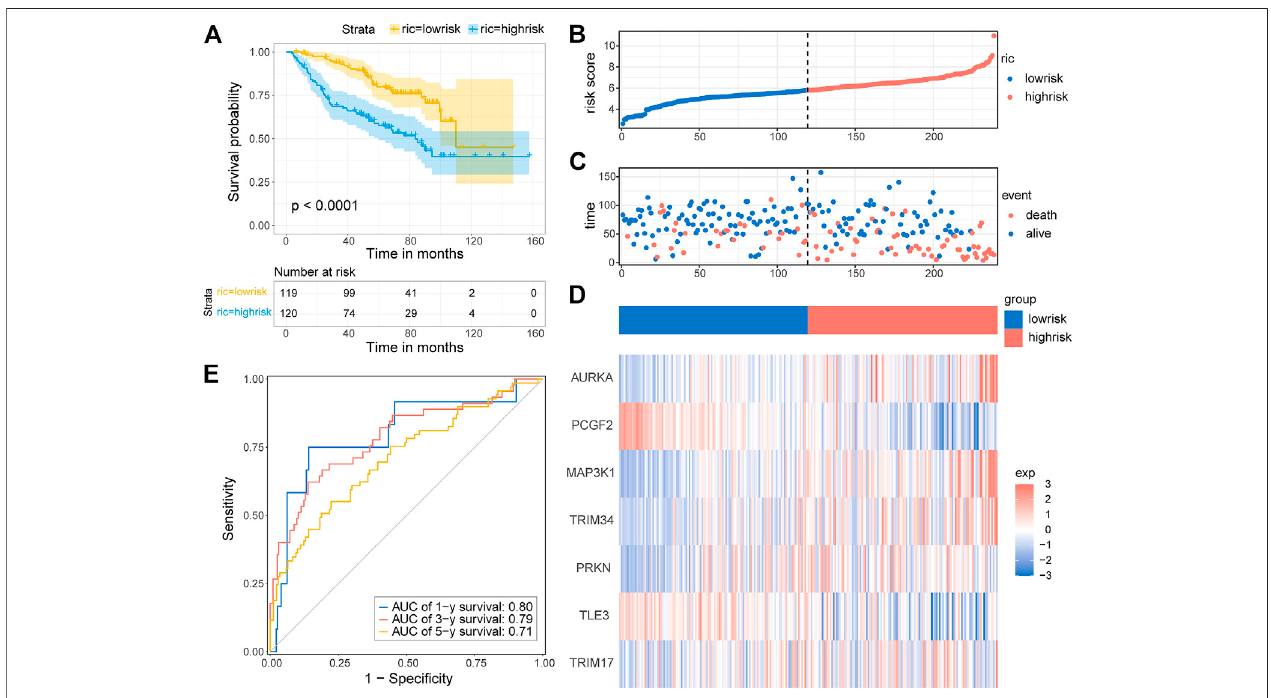
FIGURE 6 | Validation of the E3RG prognostic signature in the CGGA cohort. (A) Kaplan – Meier curves of the overall survival in the high-risk group and low-risk groupoftheCGGAcohort.Thedistributionplots (B) ,survivalstatus (C) ,andtheexpressionofsevensignaturegenes (D) intheCGGAcohort. (E) Time-dependentROC curve validation of the predictive capacity of the risk signature in the CGGA